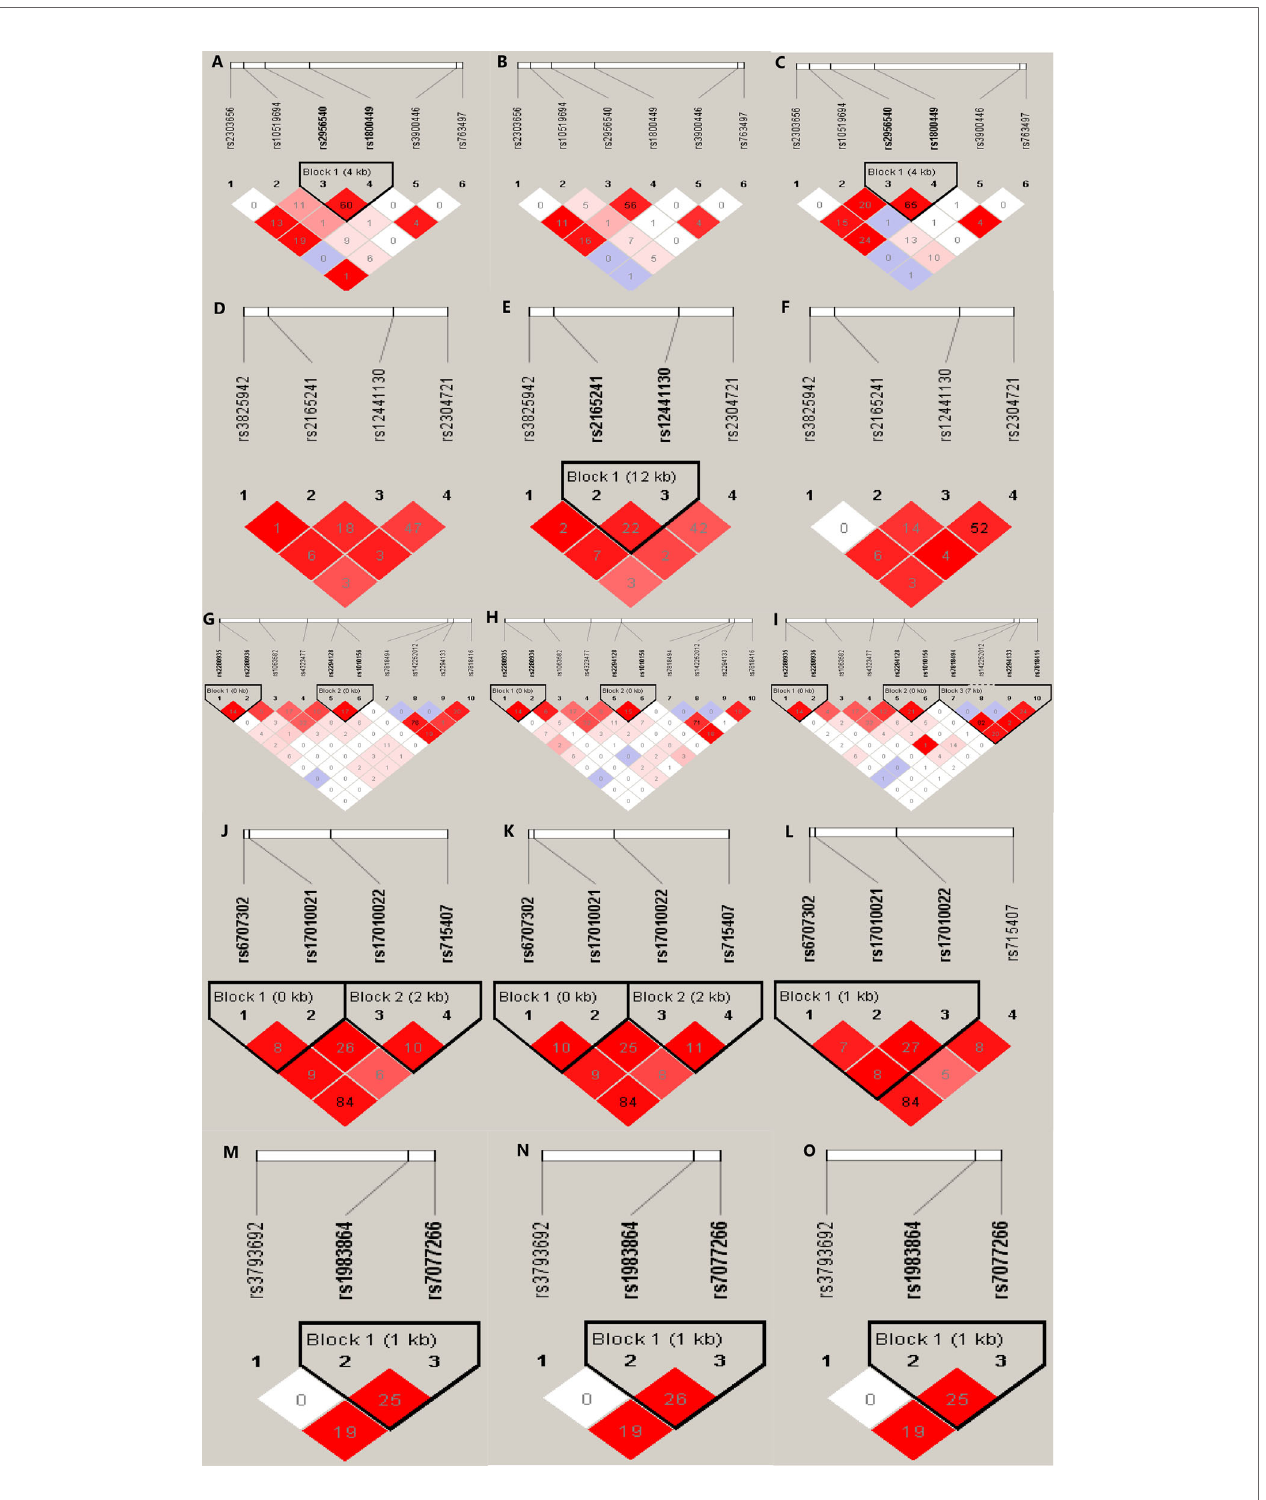
FIGURE 1 | Graphical representation of the SNP locations and LD structure of each isoform of LOX family genes. The SNP distribution and haplotype block structure across LOX family genes are shown. The measures of LD (r 2 ) among all possible pairs of SNPs are shown graphically according to the shade of color, where white represents very low r 2 and scarlet represents very high r 2 . The numbers in squares are r 2 values (r 2 × 100). The graphics (A – C) represent the SNP locations and LD structures of LOX gene in total, IA and control group, respectively. Accordingly, graphics (D – F) were for LOXL1 , graphics (G – I) were for LOXL2 , graphics (J – L) were for LOXL3 and graphic (M – O) were for LOXL4 , respectively.